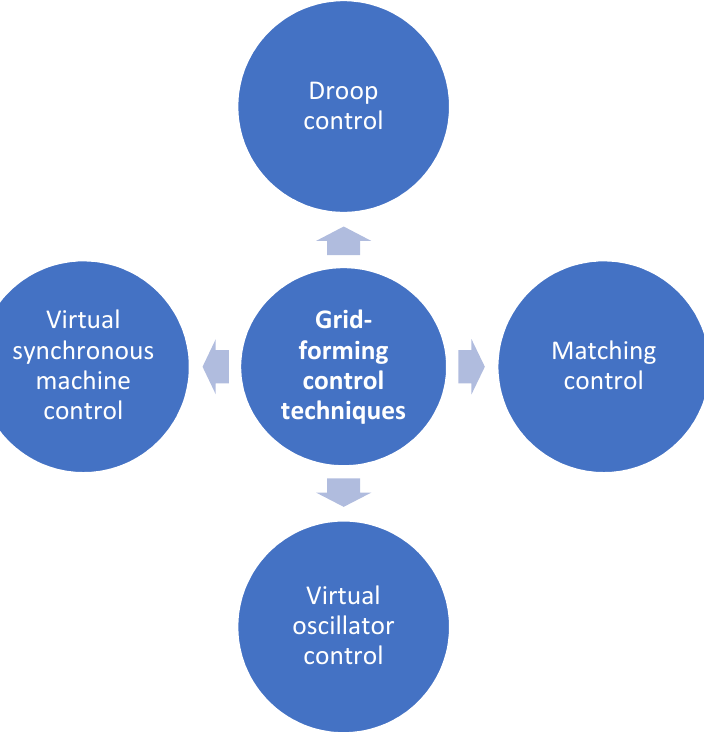
Figure 11. Different techniques used in grid-forming converters.